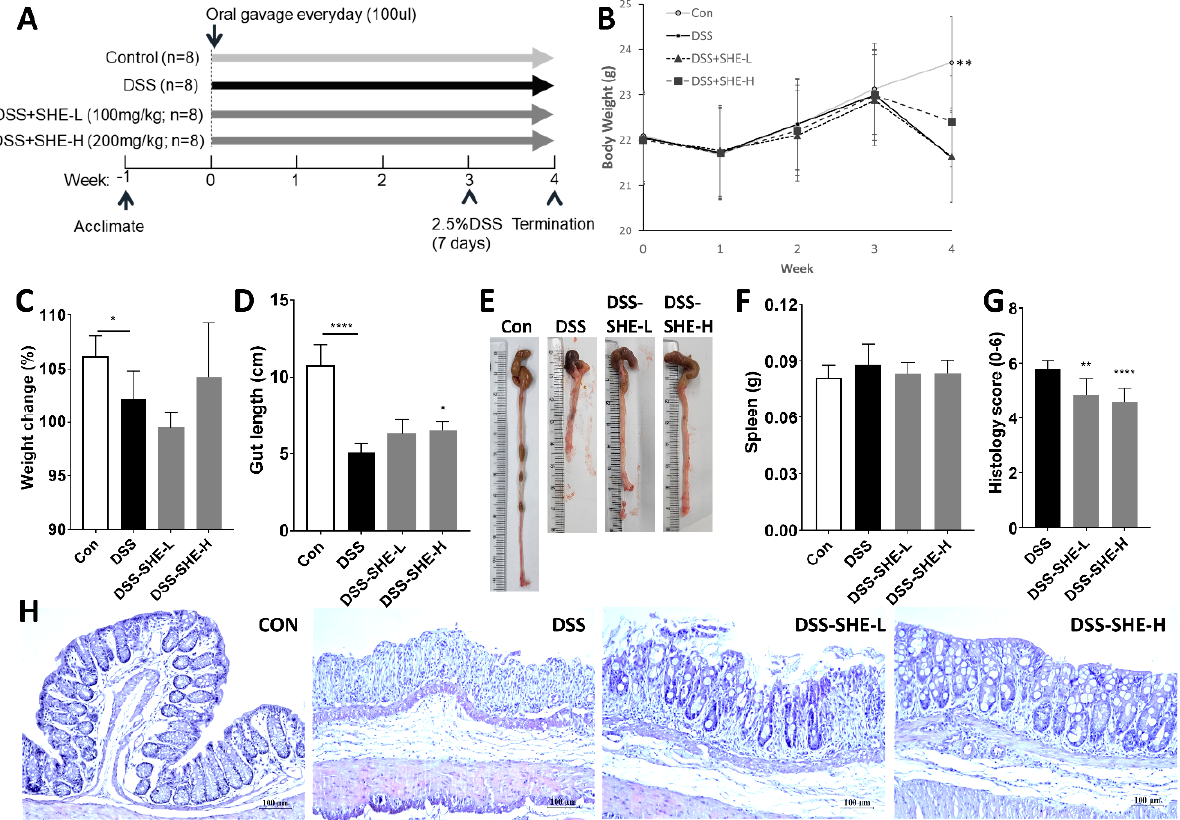
Figure 4. Effects of S. horneri extract (SHE) on DSS-induced colitis. ( A ) Experimental timeline for the mouse model of DSS. ( B ) Body weight was measured weekly throughout the experiment, and ( C ) body weight changes (%) for four weeks were calculated. Measurements included ( D ) colon lengths, ( E ) a representative image of colon lengths, and ( F ) spleen weights. ( G ) Histological alterations of colon tissue were determined. The score was based on a 0–6 scale. Colon images stained with hematoxylin and eosin (H&E) were used to assess the level of inflammation and ulceration. ( H ) Representative photographs of H&E-stained colonic tissues (magnification × 400). All data are expressed as means ± SD ( n = 8). * p < 0.05, ** p < 0.01, **** p < 0.0001, significantly different compared with DSS group by one way ANOVA followed by Dunnett’s test. CON: control group; DSS: 2.5% DSS in